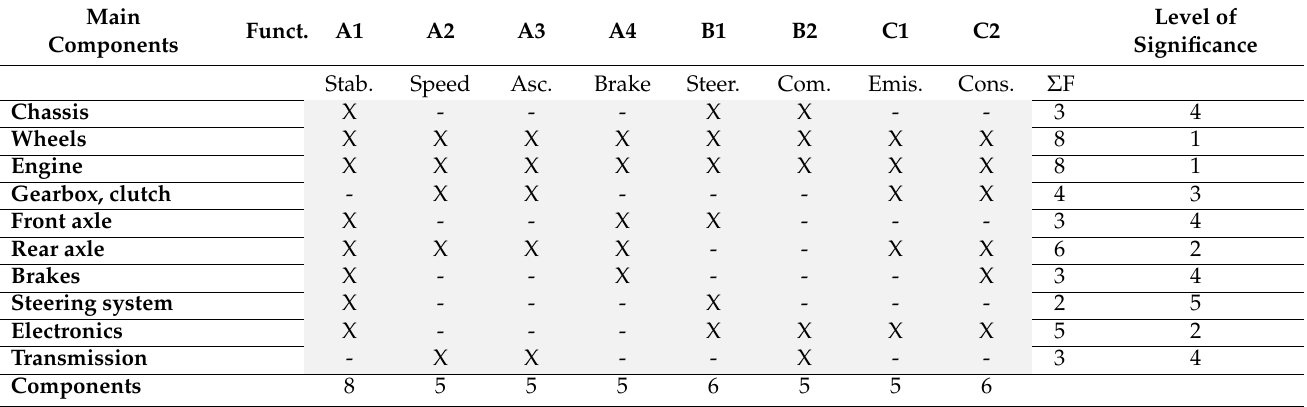
Table 2. Initial matrix–structure matrix.